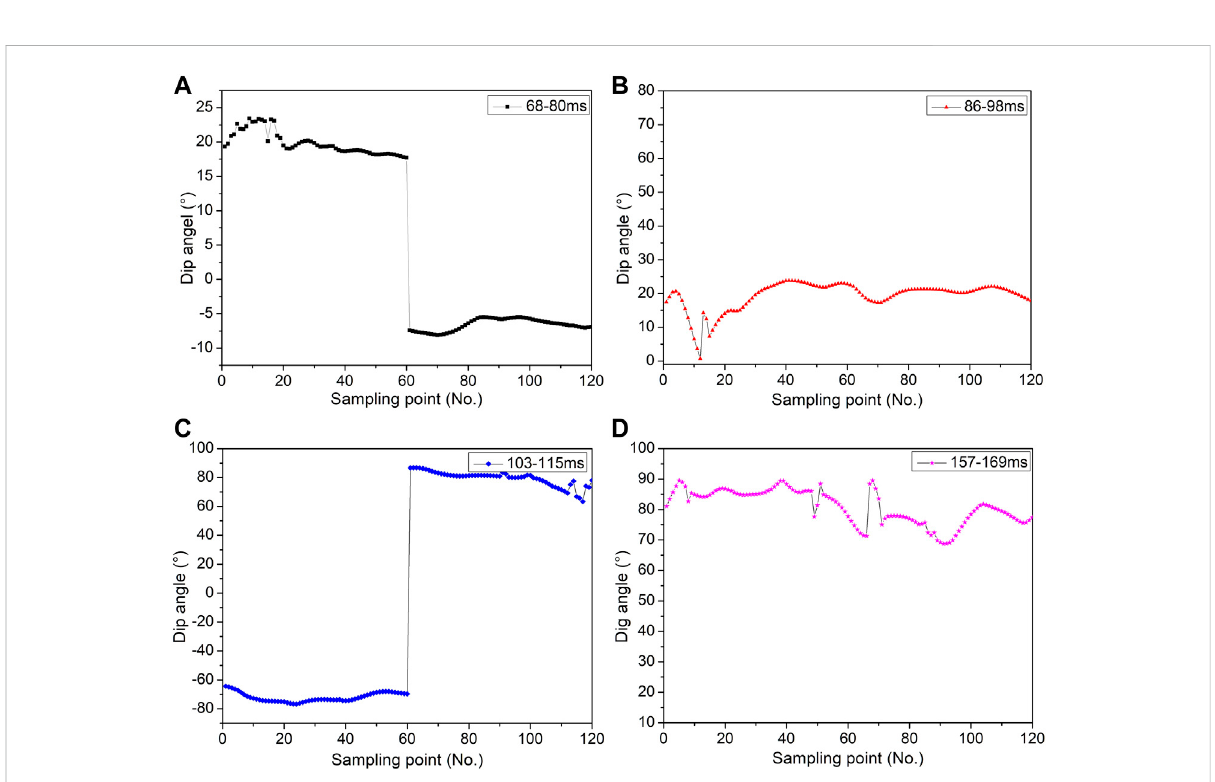
FIGURE 12 Polarization parameters of the receiver No.10 in the model. (A) 68 – 80 m; (B) 86 – 98 m; (C) 103 – 115 m; (D) 157 – 169